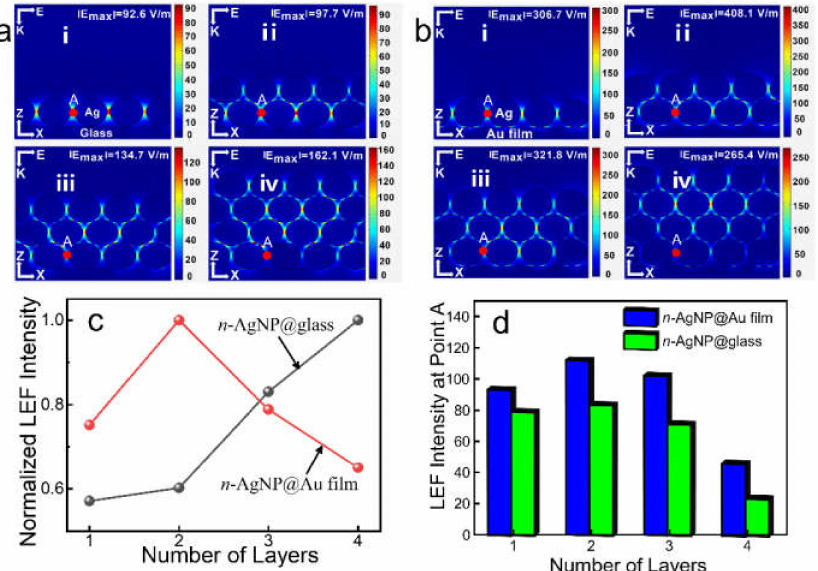
Figure 1. LEF distribution simulation results of ( a ) the n -AgNP@glass and ( b ) the n -AgNP@Au film. ( c ) Normalized maximum LEF intensity of the n -AgNP@glass and the n -AgNP@Au film. ( d ) The maxi- mum LEF intensity histogram at point A of the n -AgNP@glass and the n -AgNP@Au film. n = 1, 2, 3,